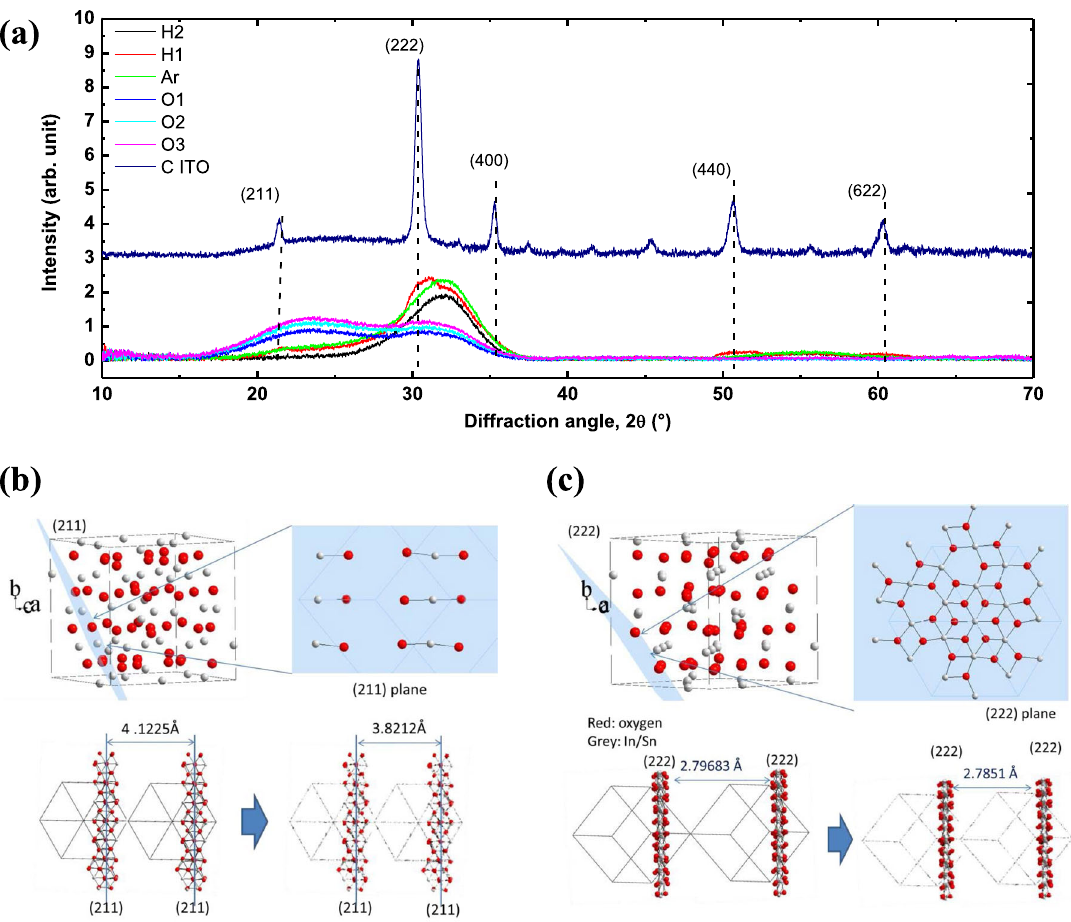
Fig. 1 Phase and structural characterization of the ITO thin fi lms. a X-ray diffraction (XRD) spectra of ITO fi lms grown on glass substrates under a pure argon environment, or at different hydrogen or oxygen partial pressures, compared with the commercial ITO. Diagrams illustrating the changes in the nano-structural arrangement in b the 1D structure of the (211) plane and c the 2D structure of the (222) plane.